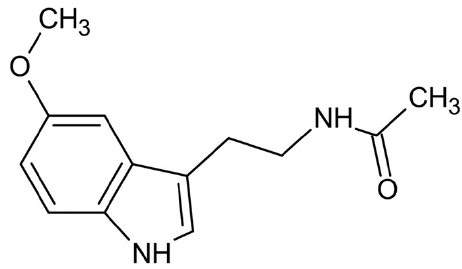
Figure 1. Chemical structure of melatonin.